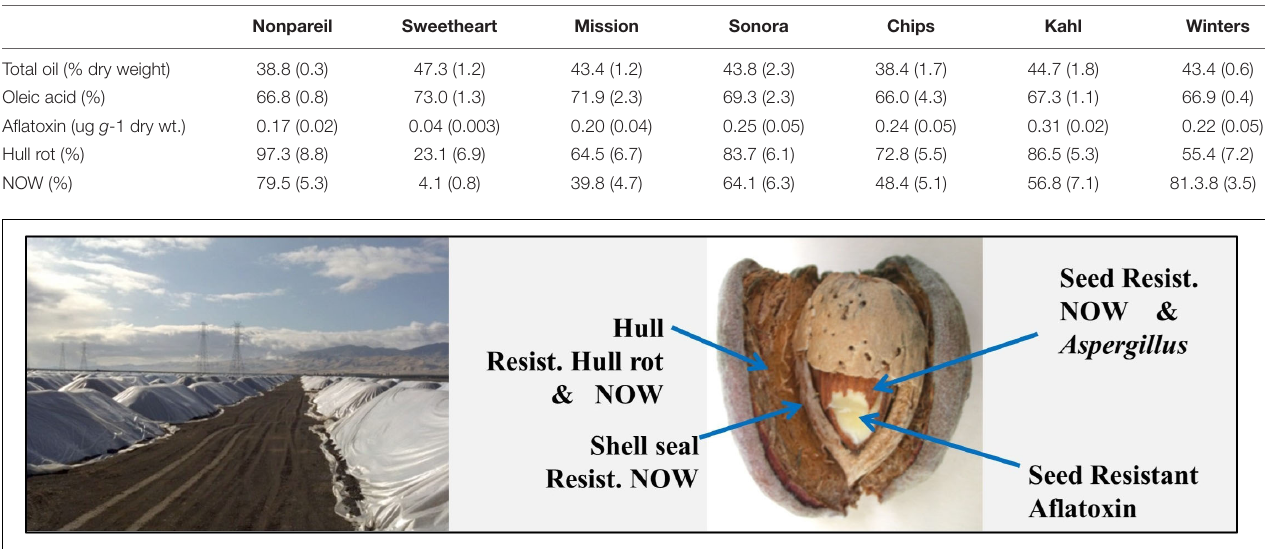
FIGURE 2 | In-field, bulk storage of almond fruit (hulls, shells, and kernels) under plastic tarps (left). Structure of the mature, dried almond fruit identifying the major components: hull, shell, and seed/seedcoat, along with associated resistances as identified in the “Sweetheart” variety (right).